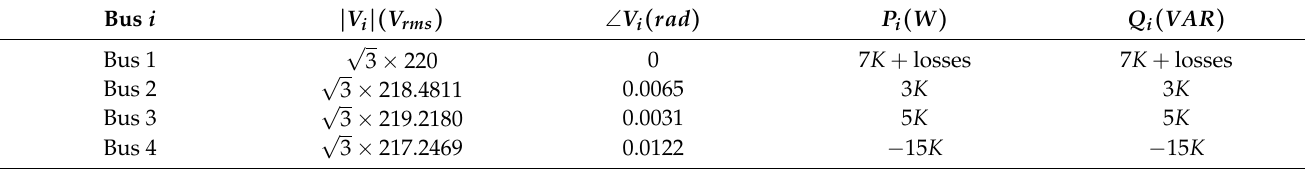
Table 2. Voltage and power details of the microgrid operation for 0 ≤ t < 0.1 s.